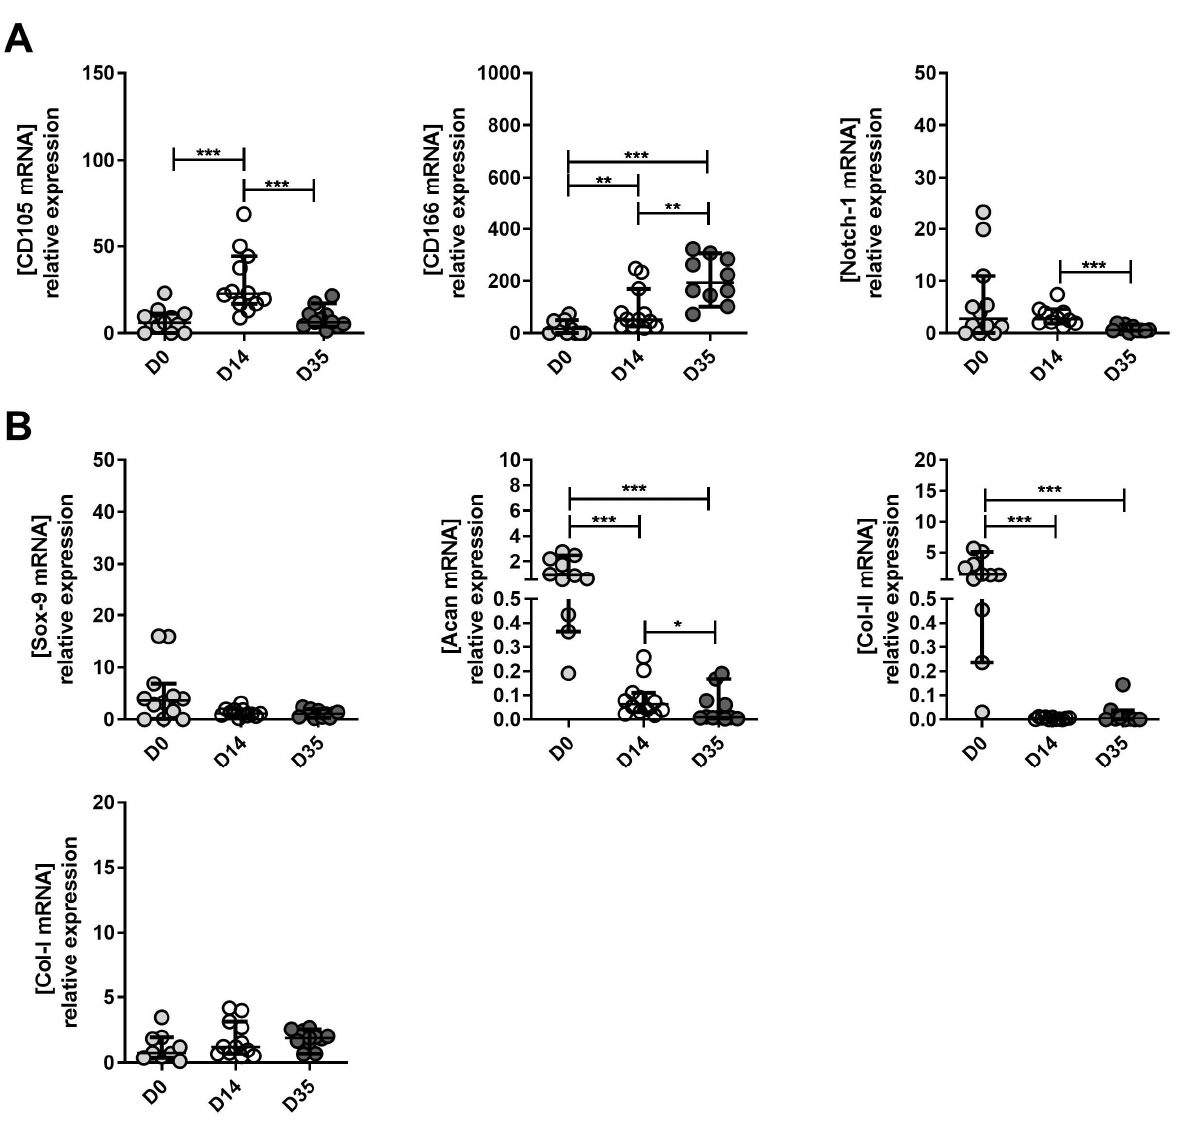
Figure 7. The expression of MPC, chondrocyte and hypertrophic chondrocyte markers between severe OA-derived tissue (D0), expanded (D14) and re-differentiated cells (D35). ( A ) Changes in mRNA expression levels of CD105, CD166 and Notch 1 (MPC markers) between D0, D14 and D35. ( B ) The changes of mRNA expression levels of Sox9 (MPC marker), Acan and Col II (chondrocytes markers), and Col I (hypertrophic chondrocytes marker) between D0, D14 and D35. D0 is used as the control to normalize expression levels. * p < 0.05, ** p < 0.01, *** p < 0.001, non-parametric Kruskal–Wallis and Mann–Whitney test.